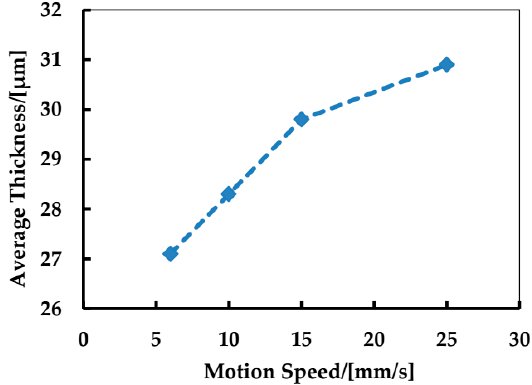
Figure 6. The average thickness profiles of the glass frit films at different speed of the substrate (6, 10, 15, 25 mm/s).